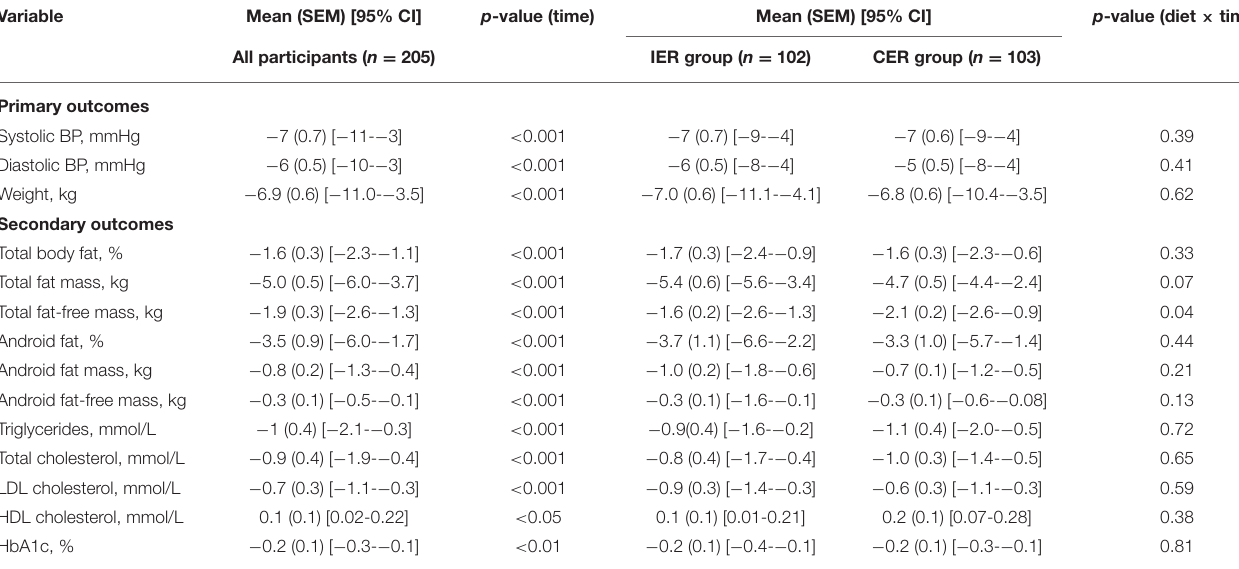
TABLE 3 | Primary and secondary outcomes from baseline to 6 months for intermittent vs. continuous groups (intention-to-treat analysis).